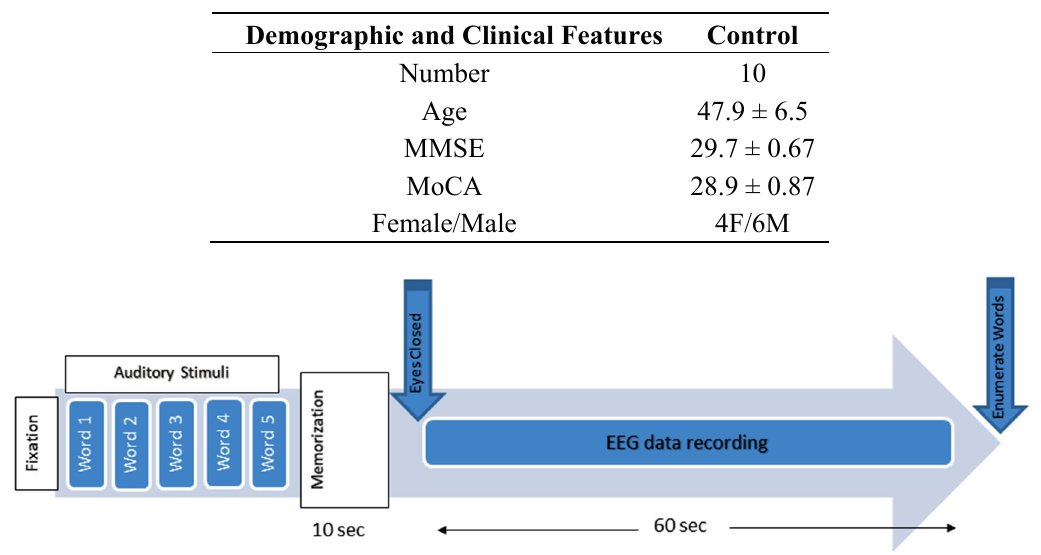
Figure 2. The working memory experimental paradigm.